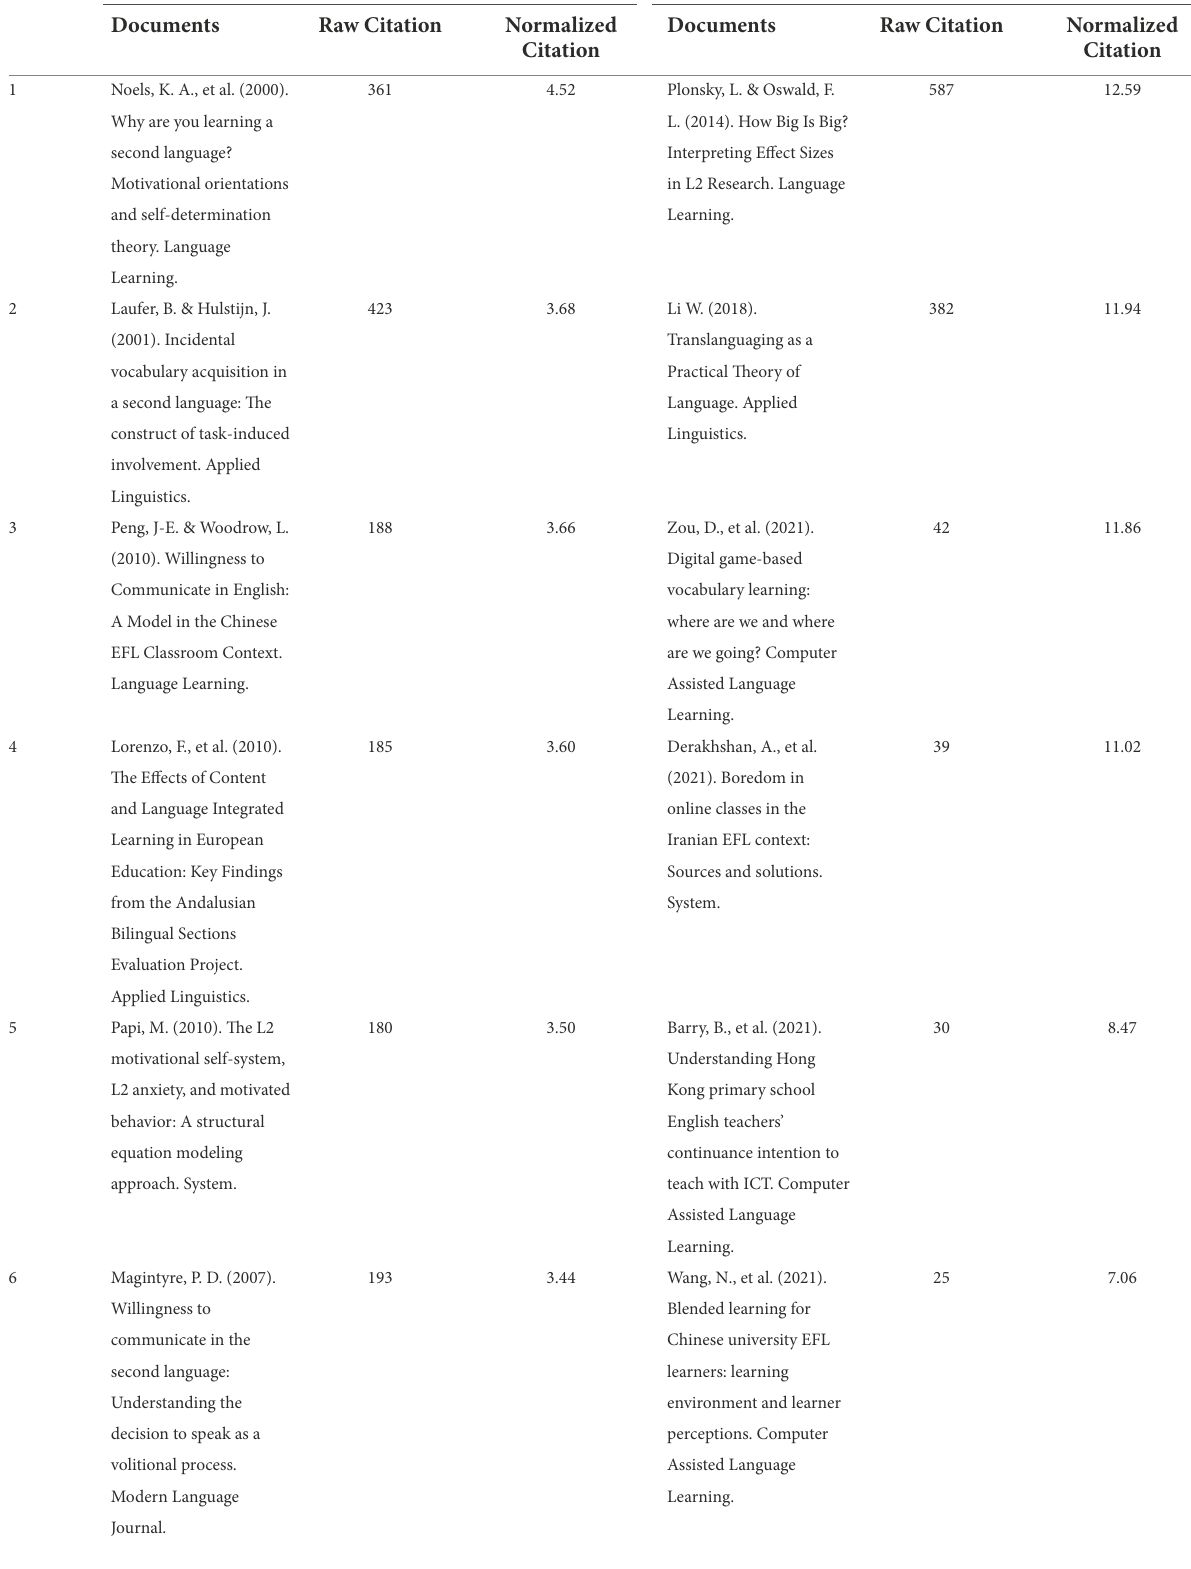
TABLE 1 The most-cited articles in the journals (order by normalized